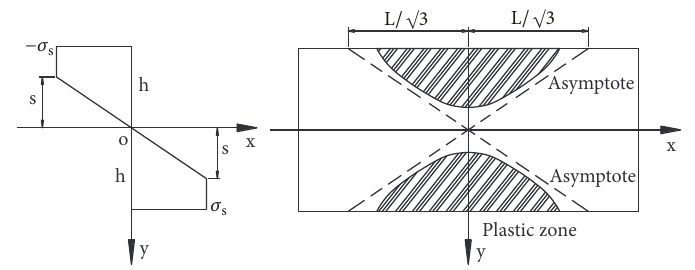
Figure 7: Plastic zone of simply supported beam.